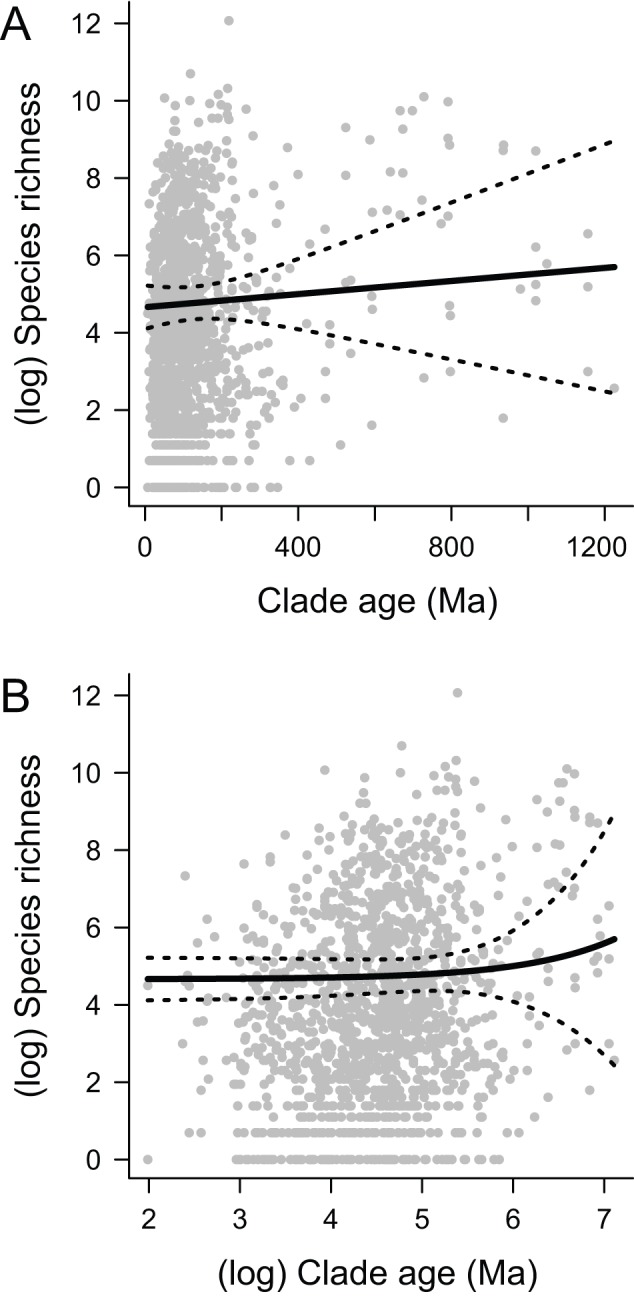
Clade age and species richness are unrelated across 1,397 clades of
multicellular eukaryotes.(A) Relationship between log(richness) and clade age (PGLS
β = 0.0008,
p = 0.66). (B) Same relationship as
(A), but fitted model is projected onto logarithmic timescale to better
visualize the relationship among age and richness for younger clades. The
regression coefficient β represents the change in log-transformed
diversity per million years.